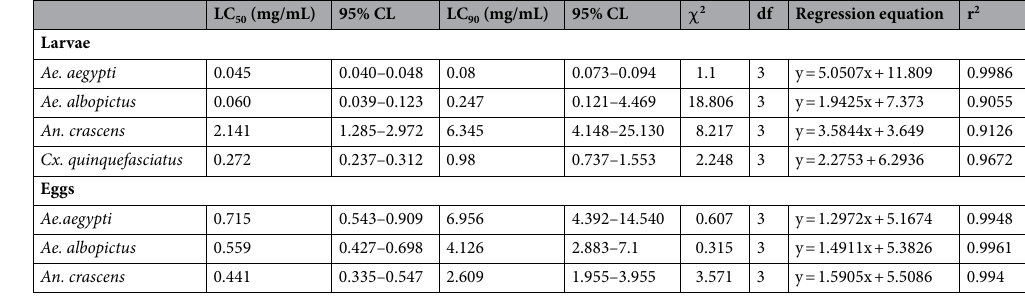
Table 2. Lethal concentrations of Streptomyces sp. KSF103 EA extract on the larvae (24 h exposure) and eggs (up to 168 h post-treatment) of Ae. aegypti , Ae. albopictus , An. cracens and Cx. quinquefasciatus (larvae only) (n = 1200). LC 50 lethal concentration that kills 50% of the exposed organisms, LC 90 lethal concentration that kills 90% of the exposed organisms, UCL upper confidence limit, LCL lower confidence limit, χ 2 Chi square, df degrees of freedom, r 2 regression co-efficient.